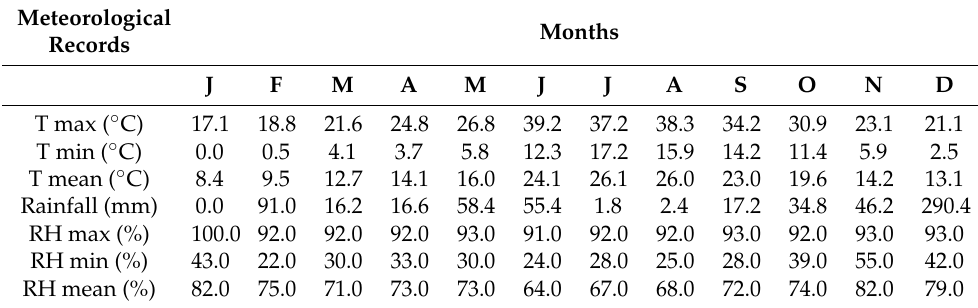
Table 2. Meteorological parameters recorded in the experimental field (Fenosu site) during 2019. T = air temperature; RH = relativity